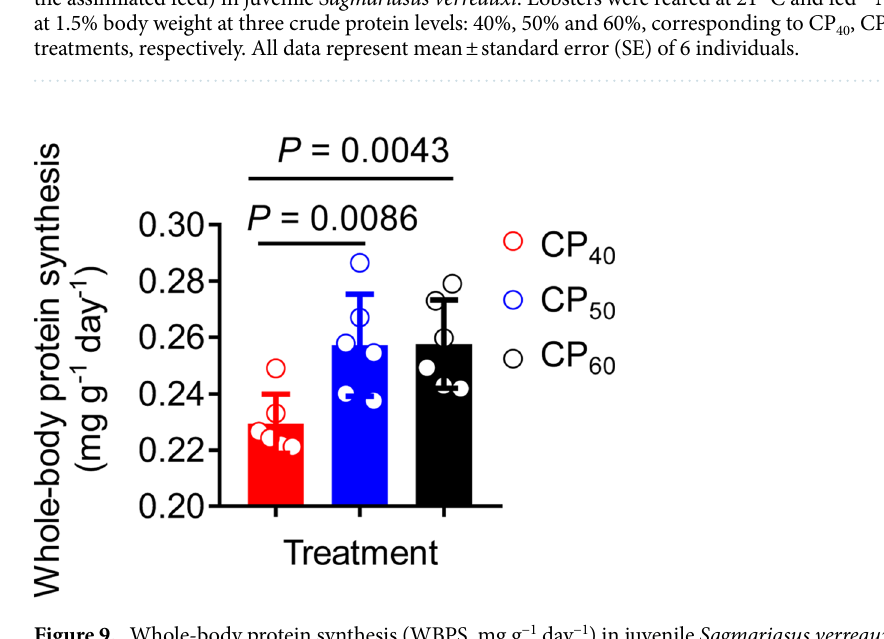
Figure 9. Whole-body protein synthesis (WBPS, mg g −1 day −1 ) in juvenile Sagmariasus verreauxi estimated over 48 h post-feeding. Lobsters were reared at 21 °C and fed 15 N-labeled feeds at 1.5% body weight at three crude protein levels: 40%, 50% and 60%, corresponding to CP 40 , CP 50 and CP 60 treatments, respectively. All data represent mean ± standard error (SE) of 6